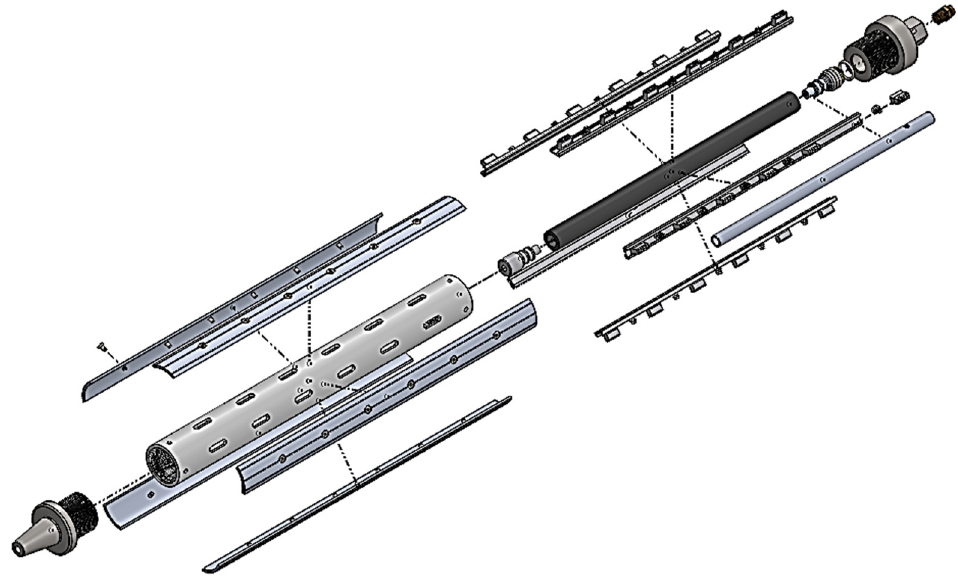
Figure 10. Expandable pneumatic shaft’s exploded view.